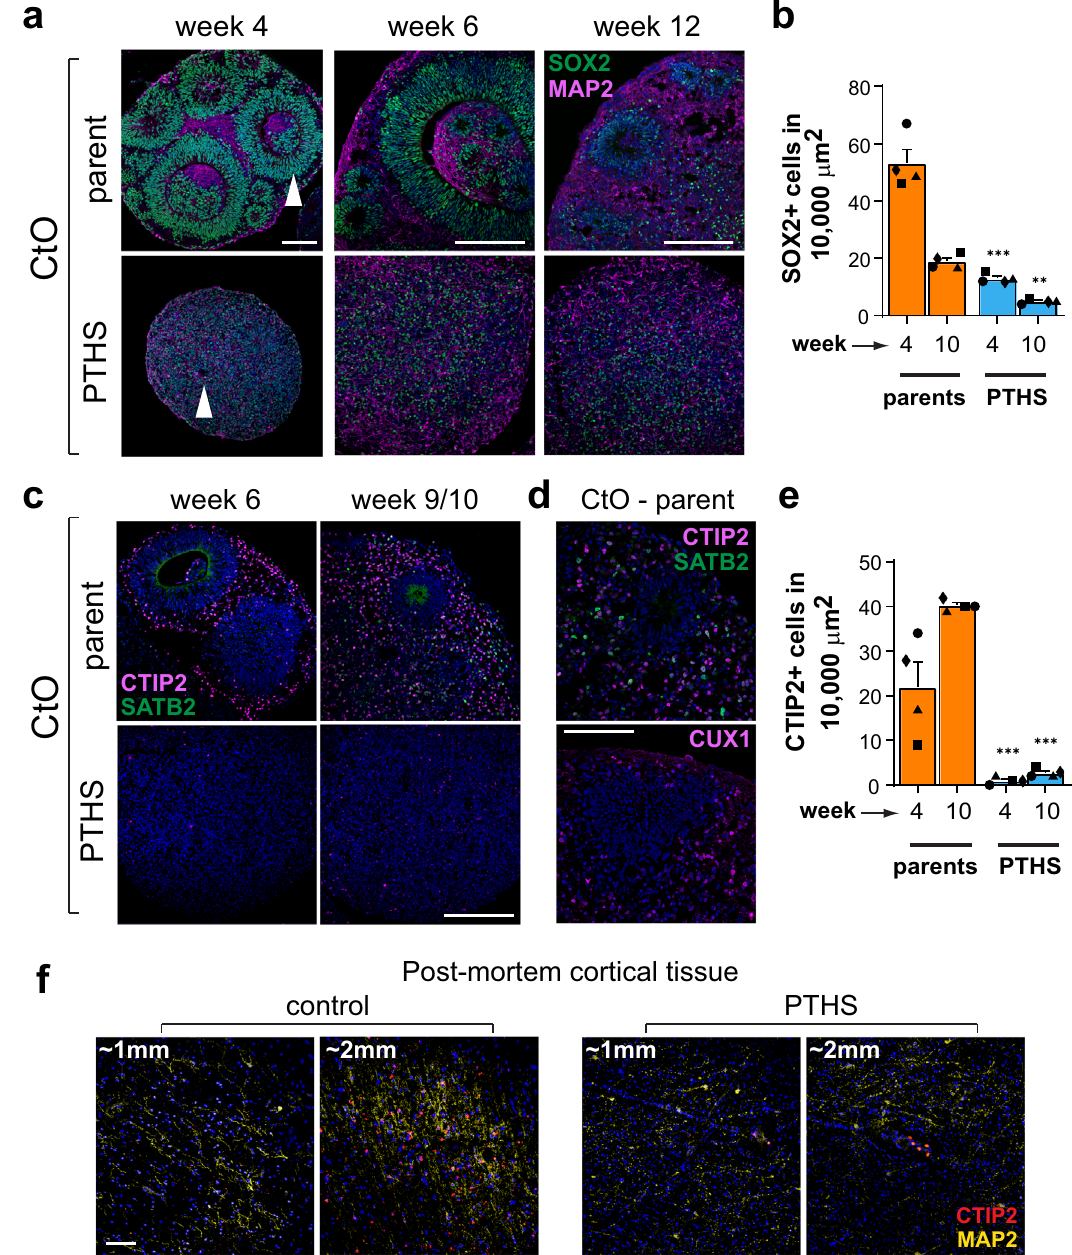
Fig. 2 PTHS organoids display altered content of neural progenitors and cortical neurons. a Fluorescence microscopy images of parent and PTHS CtOs at different developmental stages after immunostaining for neural progenitor marker SOX2 and neuronal marker MAP2. Arrowheads indicate